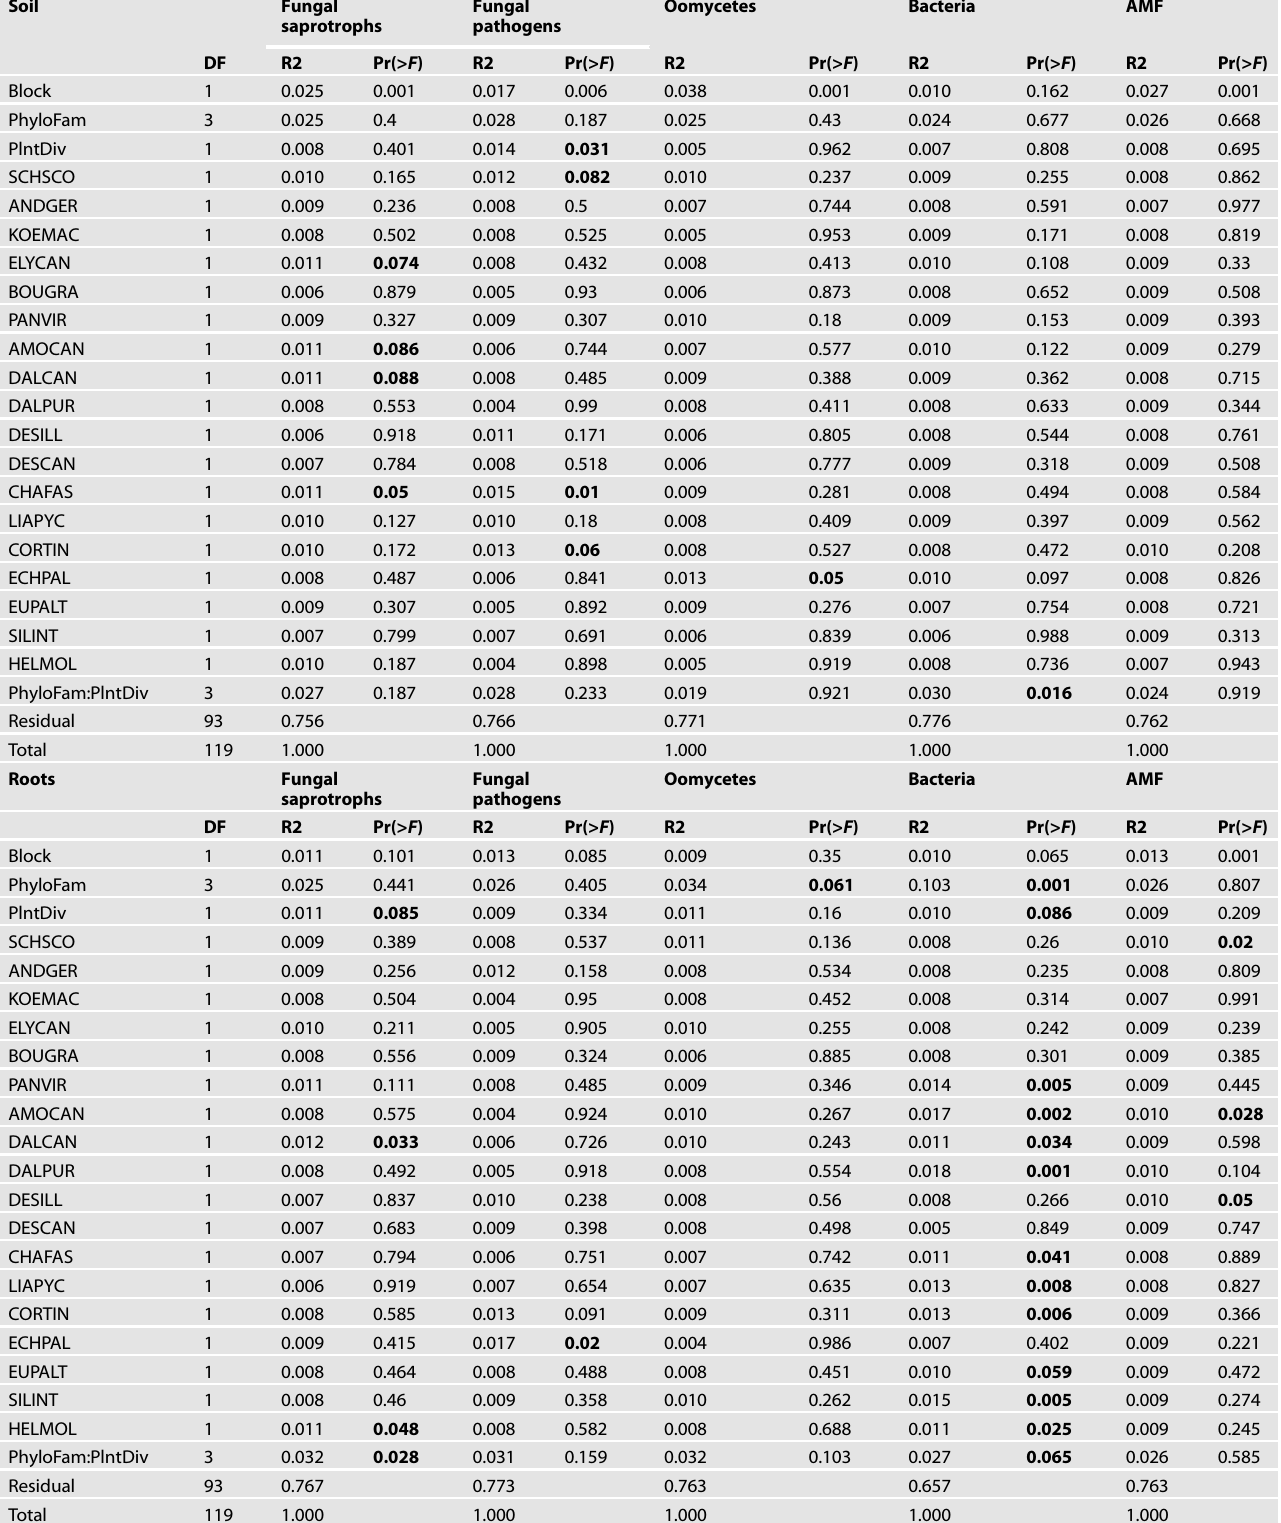
Table 2. PERMANOVA table for soil community composition (Bray − Curtis dissimilarity) response to experimental design.